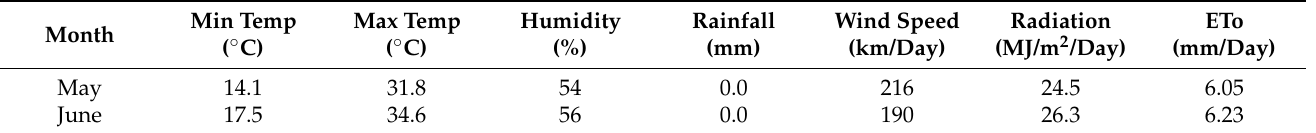
Table 1. Weather data of El-Khatatba, Menoufia, Egypt and reference crop evapotranspiration (ETo) of the plum as the average of the 2019 and 2020 seasons.